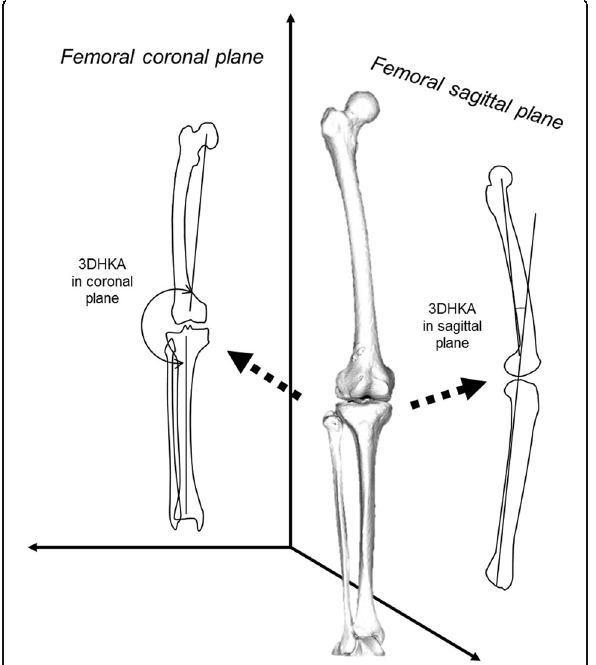
Fig. 3 Schematic illustration of coronal and sagittal alignment in a three dimensional space